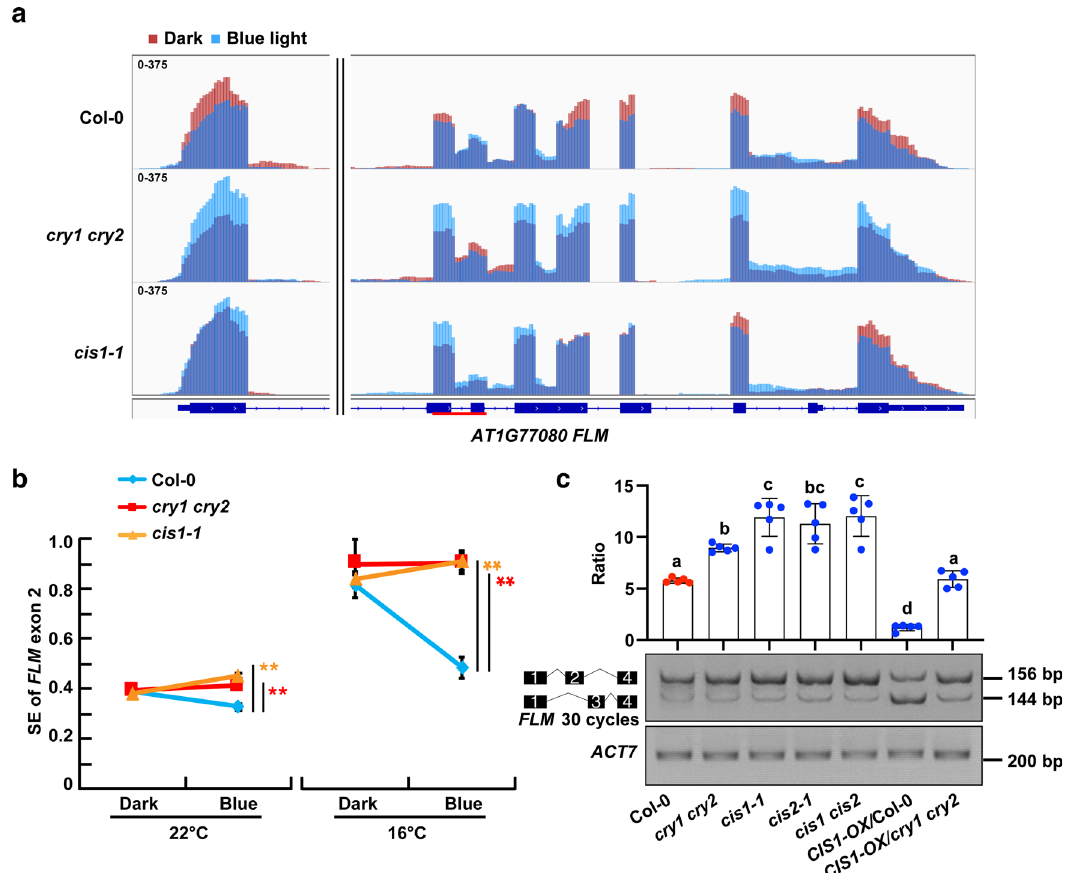
Fig. 4 | Blue light and CRYs modulate FLM AS via CIS1. a Integrative Genomics Viewer genome browser view showing AS of FLM in Col-0, cry1 cry2 , and cis1-1 at 22°C as detected by transcriptome deep sequencing (RNA-seq). Dark red (Dark) and blue (Blue light, 30 μ molm − 2 s − 1 for 3h) bars represent three biological repli- cates. The red line in the gene diagram indicates the position of AS events in FLM . b RT-qPCR validation blue light-regulated splice pattern of FLM in etiolated seed- lingsat22and 16°C.Blue light-regulated splicing ef fi ciency(SE)of FLM exon 2was calculated as a proportion to total FLM transcripts. Error bars represent the s.d.